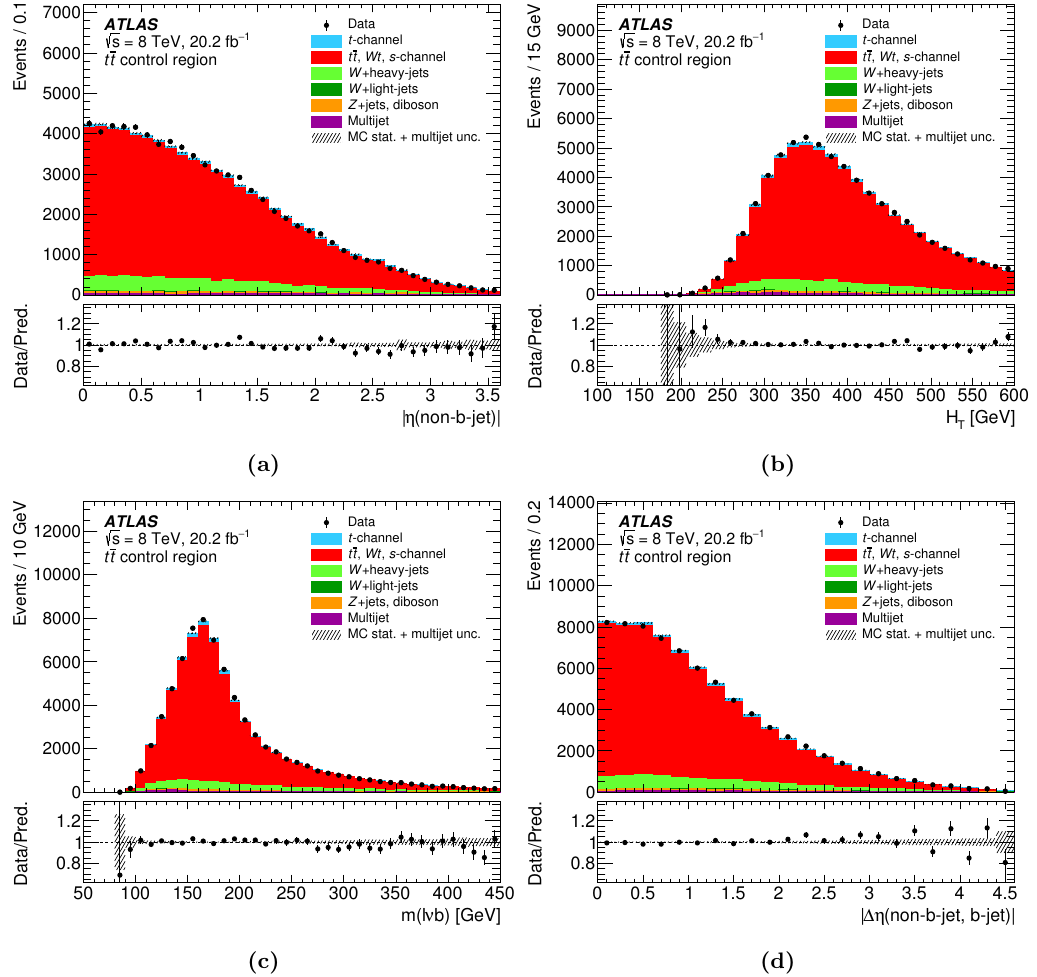
Figure 4. Distributions of (a) (cid:17) (non b -jet) , (b) the scalar sum of the p T of all (cid:12)nal-state objects, j j H T , (c) reconstructed top-quark mass, m ( ‘(cid:23)b ), and (d) (cid:1) (cid:17) (non b -jet ; b -jet) in the t (cid:22) t control region j j for the merged electron and muon channels. The multijet background is estimated using data-driven techniques, while contributions from simulated W +jets, top-quark backgrounds and t -channel event samples are normalised to the results of a maximum-likelihood (cid:12)t to event yields in the signal and control regions. The uncertainty bands correspond to the uncertainties due to the size of the simulated event samples added in quadrature with the data-driven normalisation uncertainty of 70% estimated for the multijet contribution. The lower plots show the ratio of data to prediction in each